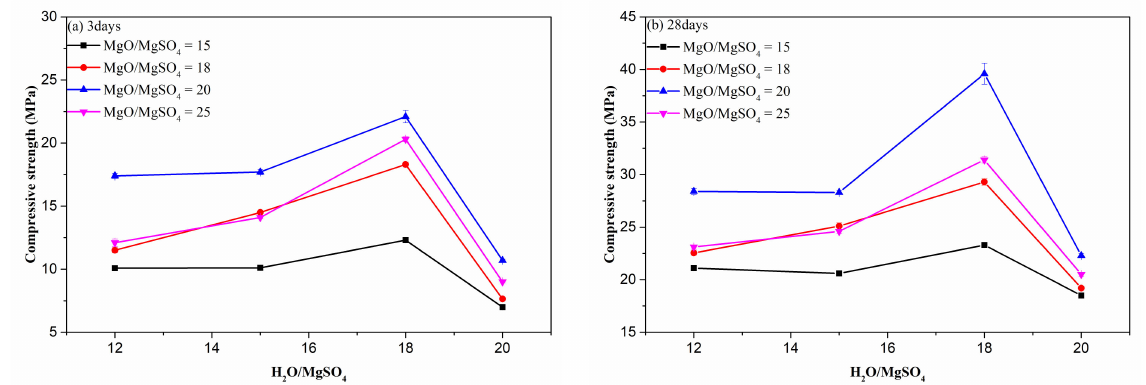
Figure 4. Influence of H/S on the compressive strength of MOS cement